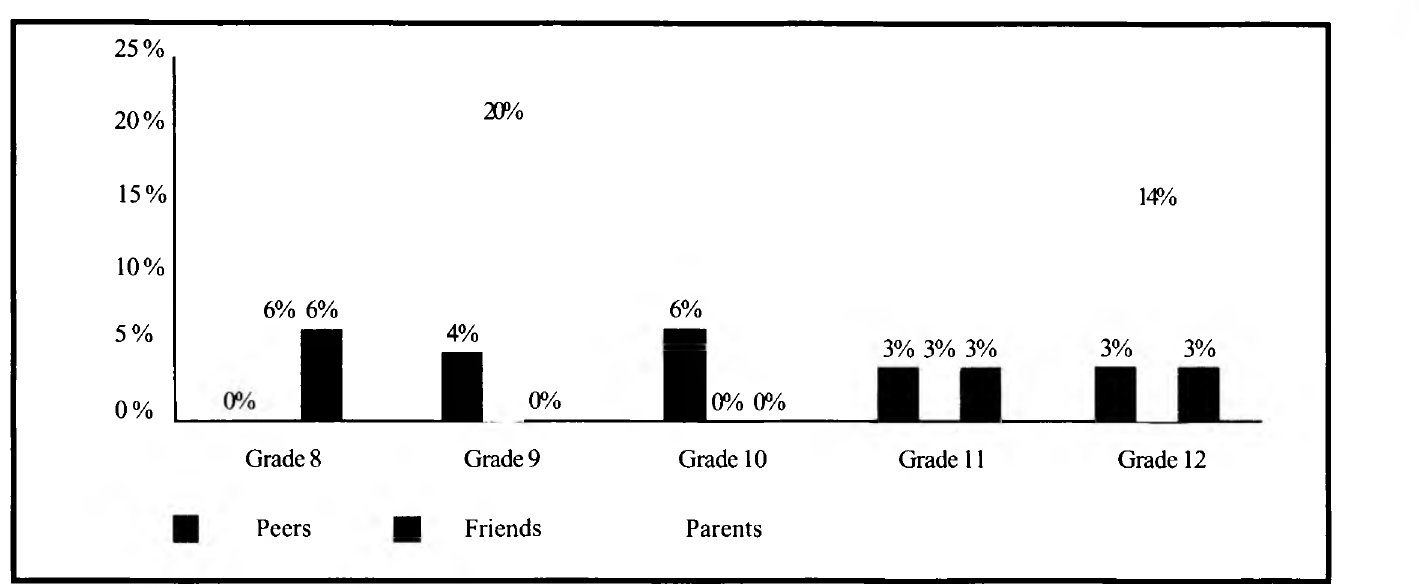
Figure 1 Sources of information about